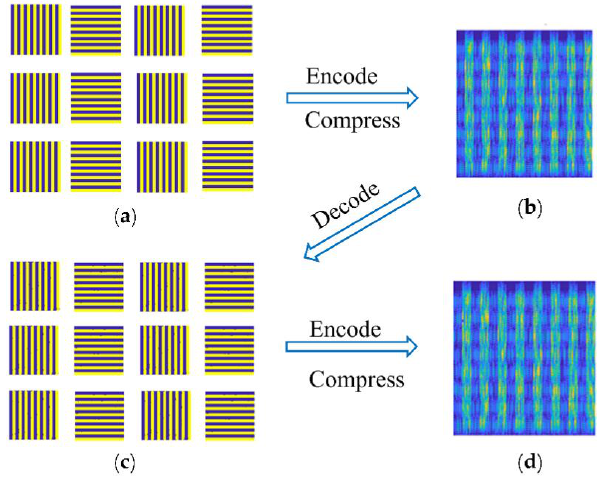
Figure 7. The whole process of our experiment: ( a ) original image sequence frames; ( b ) encoded and